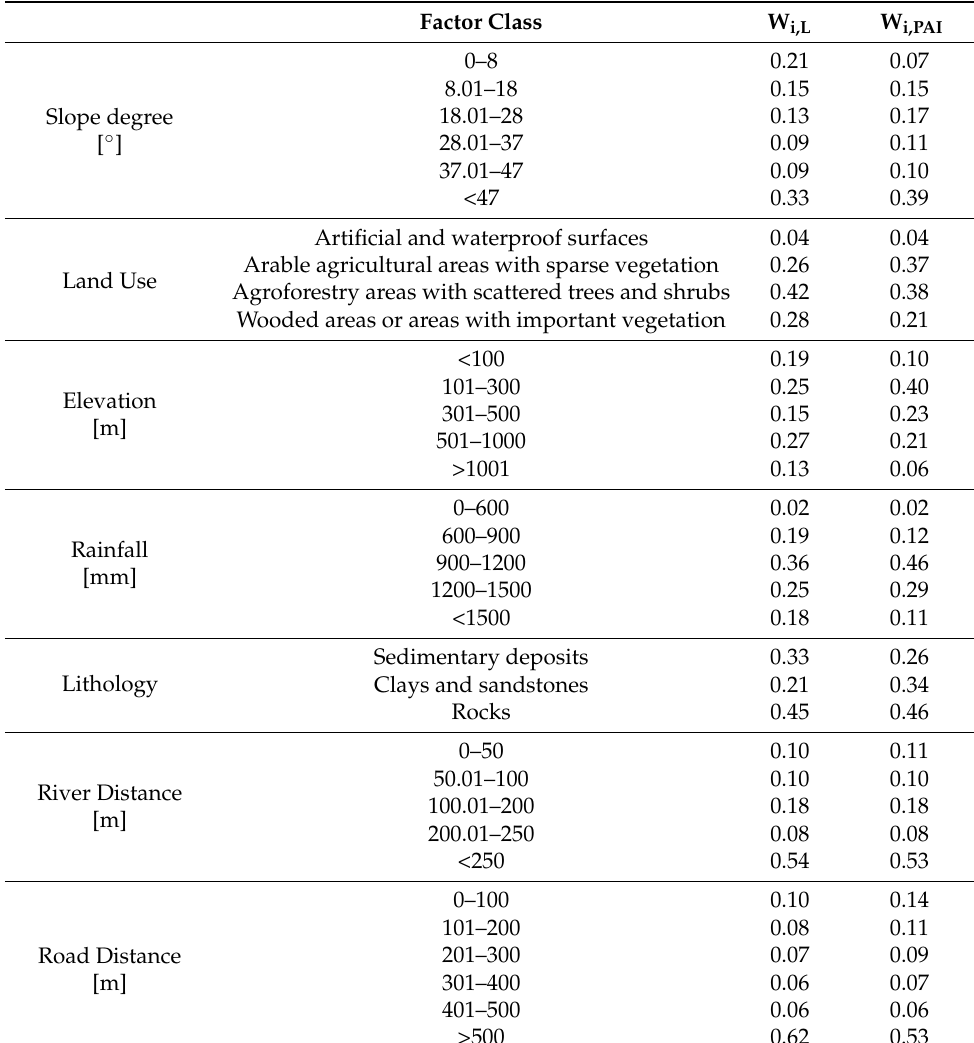
Table 2. Weight of classes of factor in the landslide areas identified by the